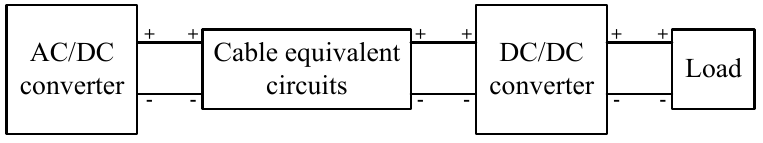
Figure 9. The block diagram of the prototype experiment configuration.